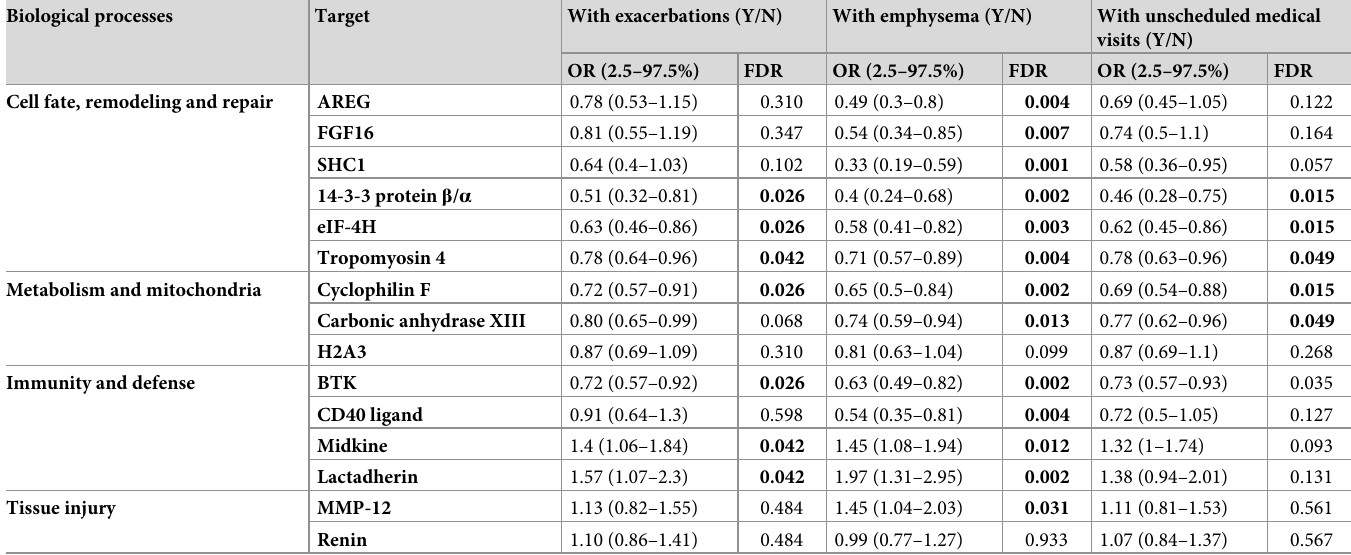
Table 3. Correlation analyses between the 15 differentially regulated proteins and main clinical parameters in COPD patients of the COBRA cohort. Biological